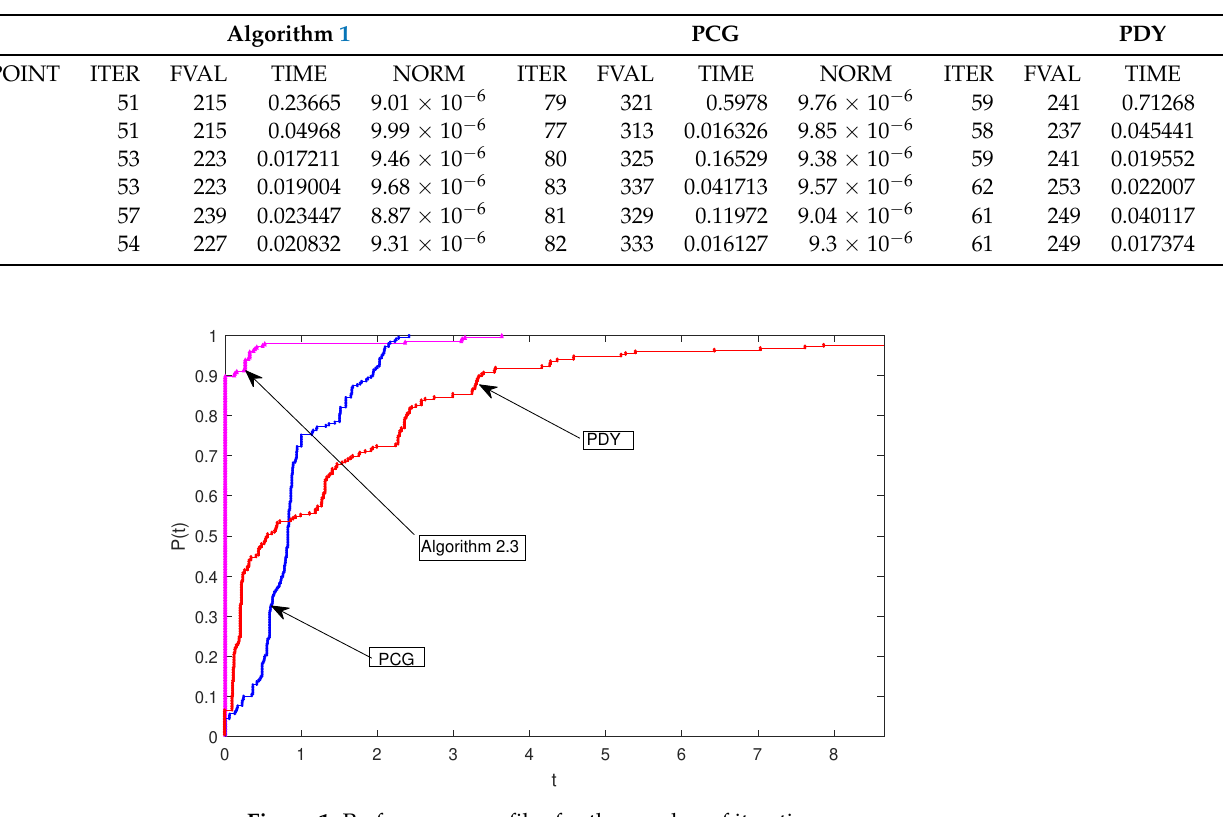
Table 9. Numerical Results for Algorithm 1 (DCG) , PCG and PDY for Problem 9 with given initial points and dimensions.